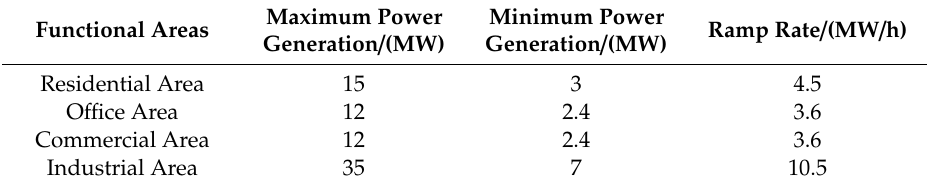
Table A2. Parameters of CHP